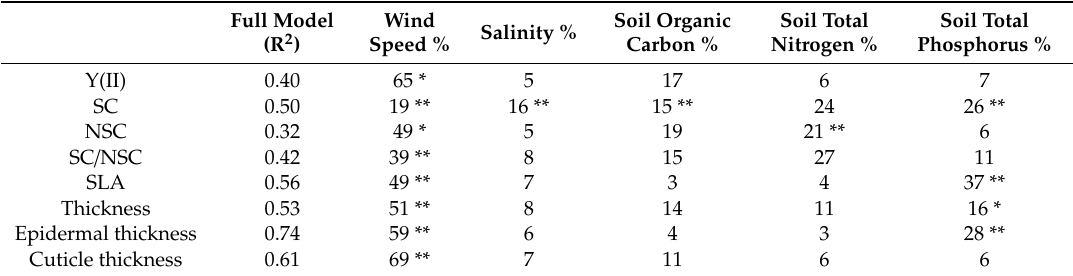
Table 3. Results of hierarchical partitioning for the e ff ects of wind speed, salinity, and soil nutrient on leaf morphology, anatomy, photosynthesis, and carbohydrate of Pinus thunbergii along the coast-inland